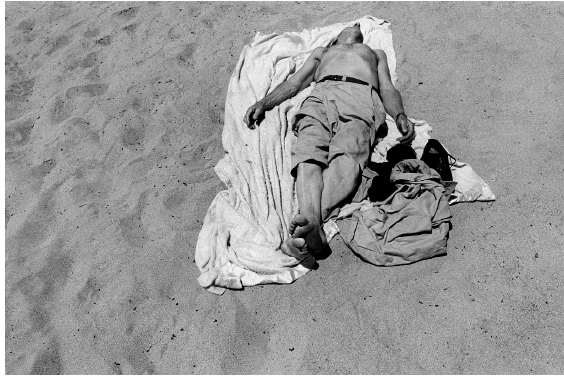
Figure 13. Anthony Hernandez, Santa Monica # 2 (1970), © Anthony Hernandez.